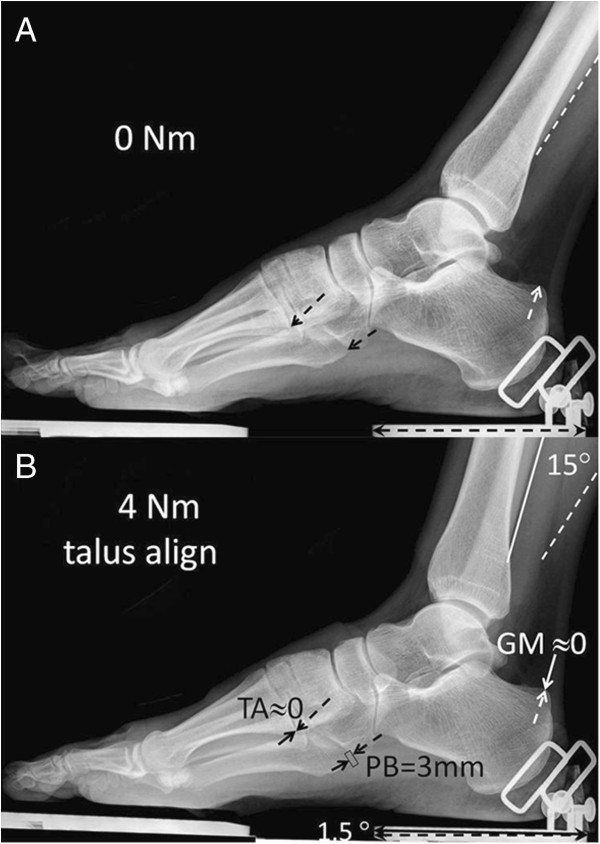
Analysis of X-rays for a TD adult subject after talus alignment. A. The foot in a position similar to that when exerting 0 Nm. Under high magnification markers (dashed lines and arrows) were placed for alignment and at particular insertion points of muscles and along the fibula. B. The foot in a position similar to that when exerting 4 Nm dorsal flexion. The talar bone was aligned with that in A. Such talar bone alignment allows distinction of contributions to foot plate movement and muscular length changes by foot deformation and crural bone movements respectively. The markers of A. were copied to image B. (dashed lines or arrows). New markers (solid lines or arrows) placed on the reference points in the new condition. Length changes were estimated (rectangles) for GM (m. triceps surae). TA (m. tibialis anterior) and PB (m. peroneus brevis) and angular changes for the fibula and foot plate, as well as calcaneal angle (not shown). The arrow on the heel part of the foot plate is used for calibration (actual dimension = 8.98 cm).